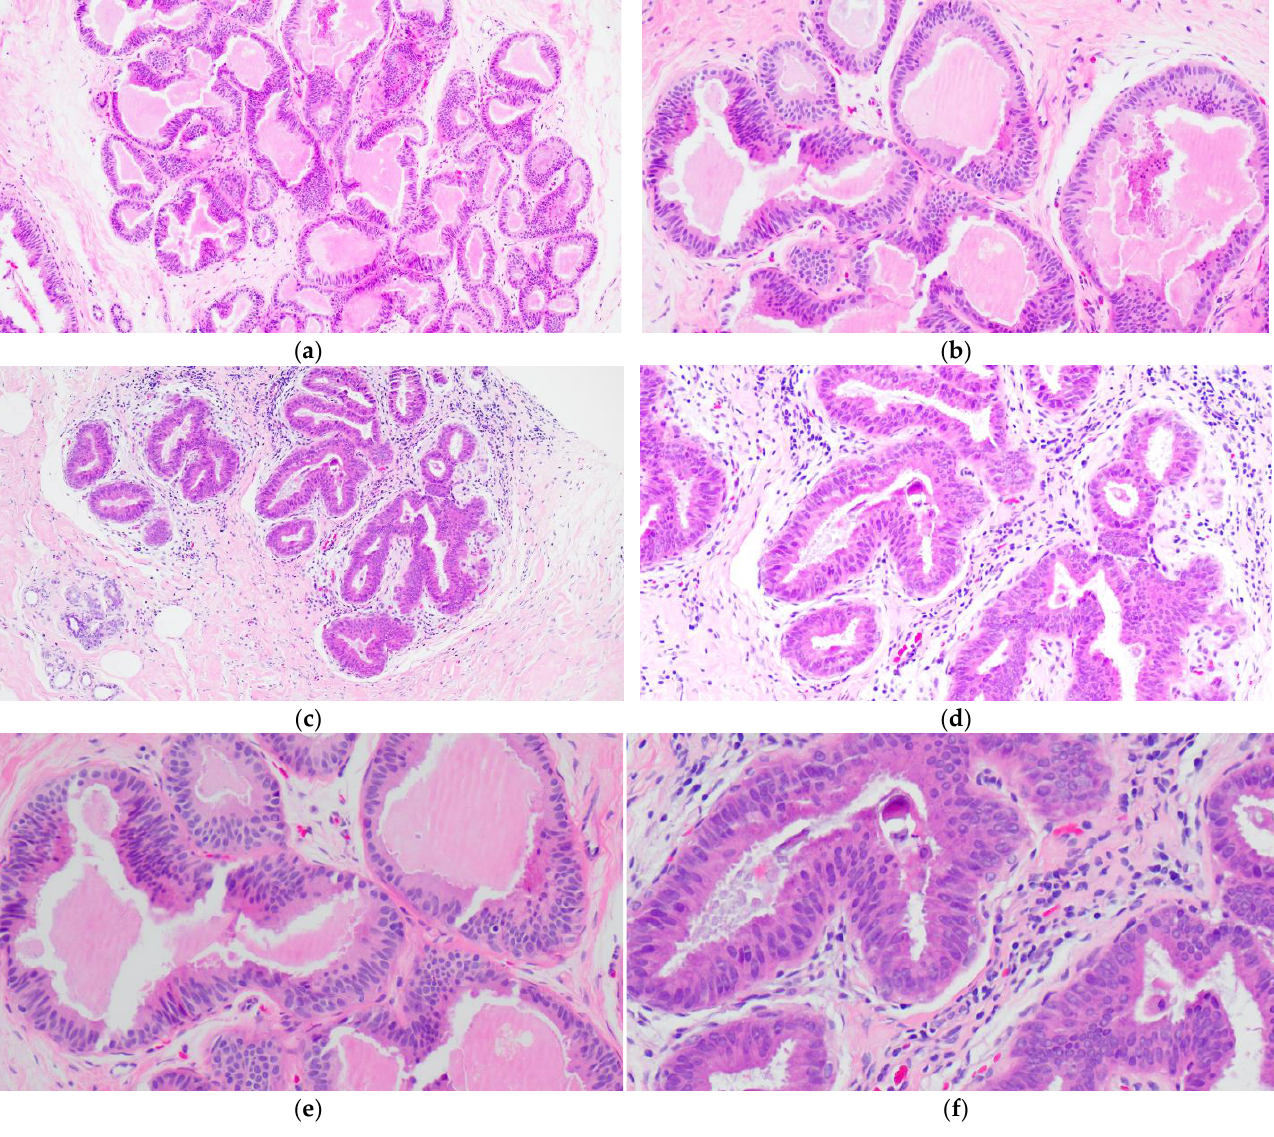
Figure 2. Columnar cell hyperplasia (CCH) showing variably dilated acini lined by more than two layers of columnar-shaped cells with ( a , c , e , f ) with nuclear crowding and overlapping, and formation of small tufts ( b , d ). There are luminal secretions ( a , b , e ) and calcifications ( c , d , f ). FEA now encompasses the term for CCLs with low-grade (monomorphic) cytologic atypia resembling the nuclei of low-grade DCIS. FEA has architectural features of CCC or CCH (Figure 3a,c), but with superimposed cytologic atypia characterized by the presence of rounded or ovoid nuclei with loss of polarity, mildly increased nuclear to cytoplasmic ratio and variably prominent nucleoli (Figure 3b,d–f). Some cases of CCL may lack such classic morphologic features but the presence focal or patchy cytologic atypia may be sufficient to warrant the diagnosis of CCL with atypia. The latter is indeed a term preferred over FEA by some pathologists. Lesions with columnar cells but more complex architectural patterns such as rigid cellular bridges, micropapillations or arcades should be classified as ADH or low-grade DCIS (Figure 4a–f). Similarly, high-grade cytologic atypia with nuclear pleomorphism of the type seen in high-grade DCIS is not a feature of lesions included in the CCL category; such lesions should be classified as high-grade